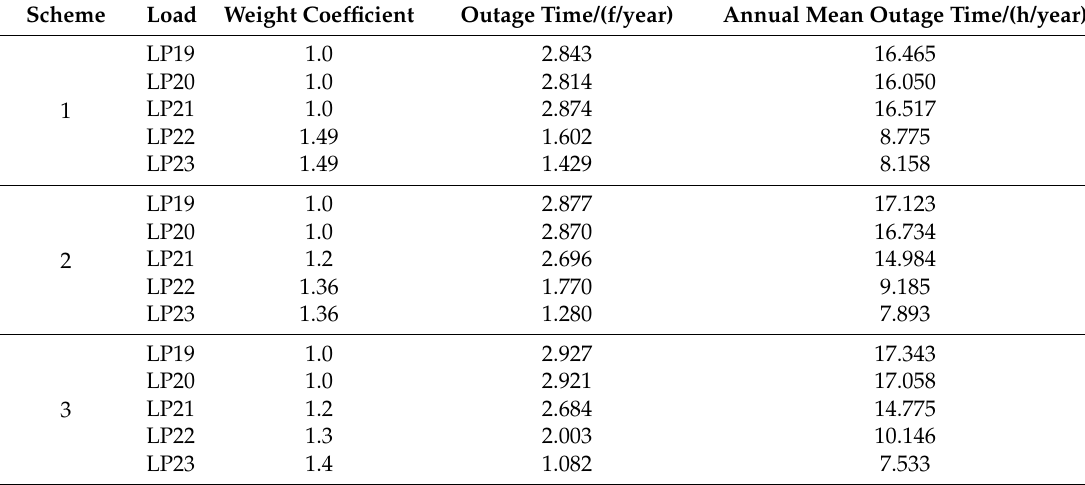
Table 2. System Reliability